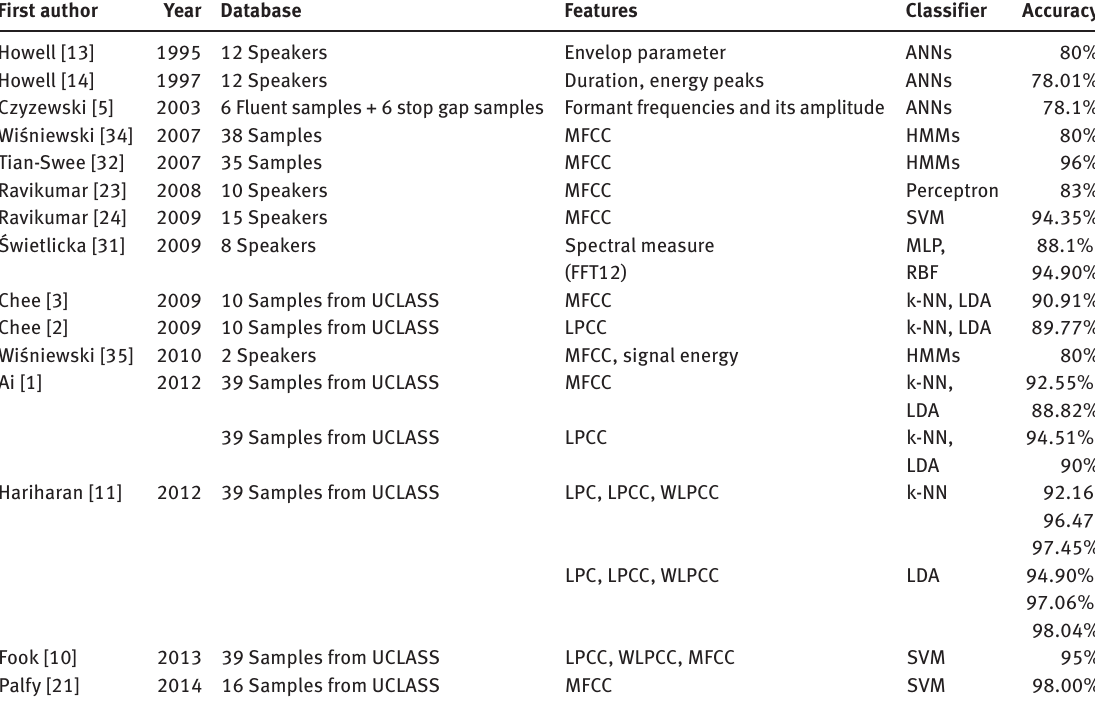
Table 1: Summary of Previous Research Works on Stuttering